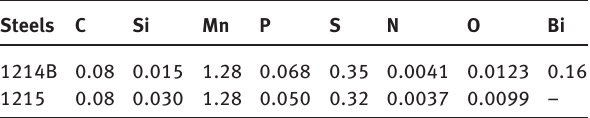
Table 1: Chemical compositions of steel materials, mass% Steels C